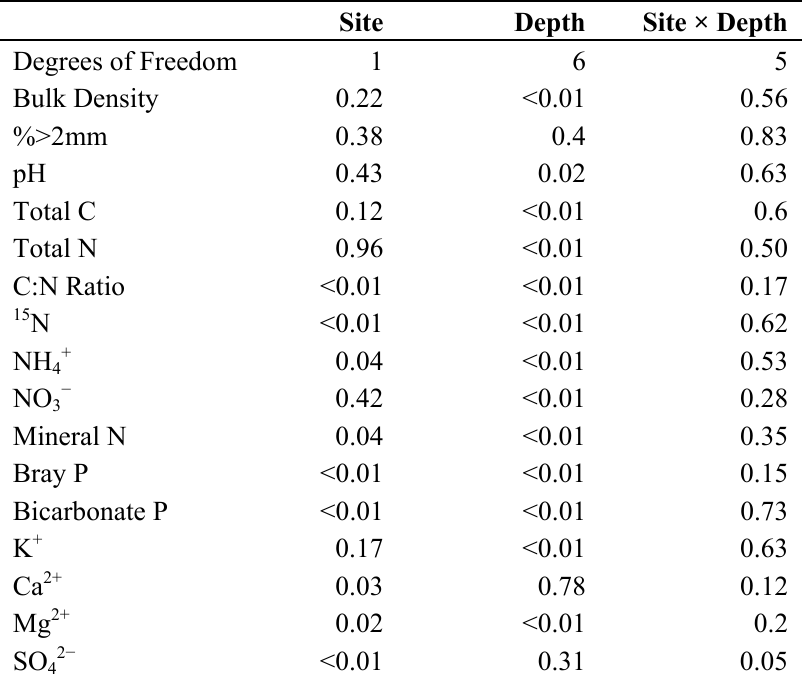
Table 2. Probability values for differences in site, depth and site × depth of log transformed soil physical and chemical data from the Sagehen